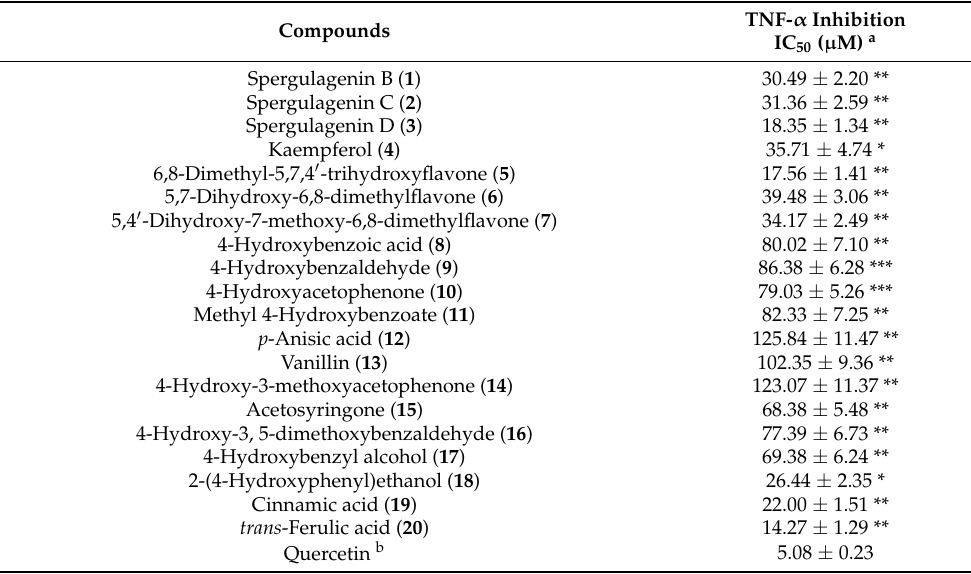
Table 4. Inhibitory effect of compounds 1 – 20 on the production of pro-inflammatory cytokine, TNF- α in LPS-stimulated RAW 264.7